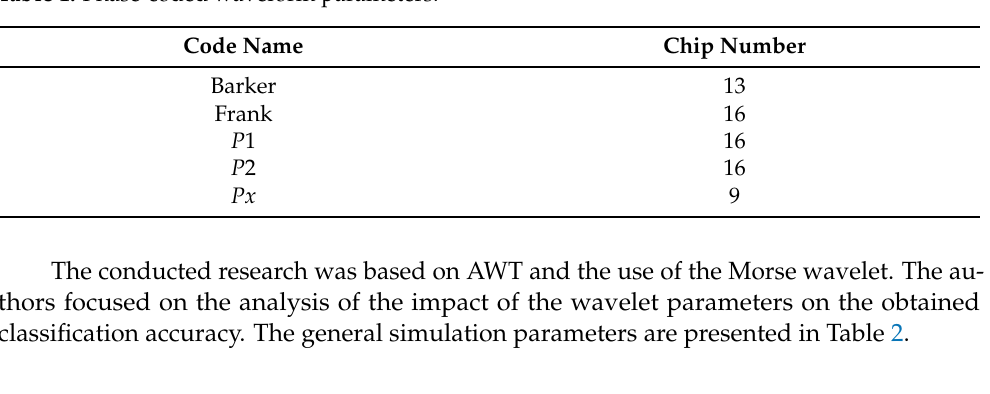
Table 1. Phase-coded waveform